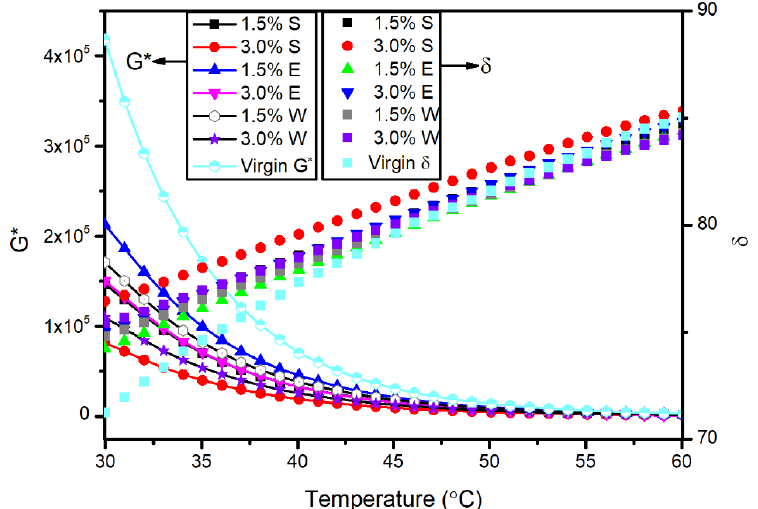
Figure 10. Complex modulus and phase angle of the asphalt with different kinds of healing agents.